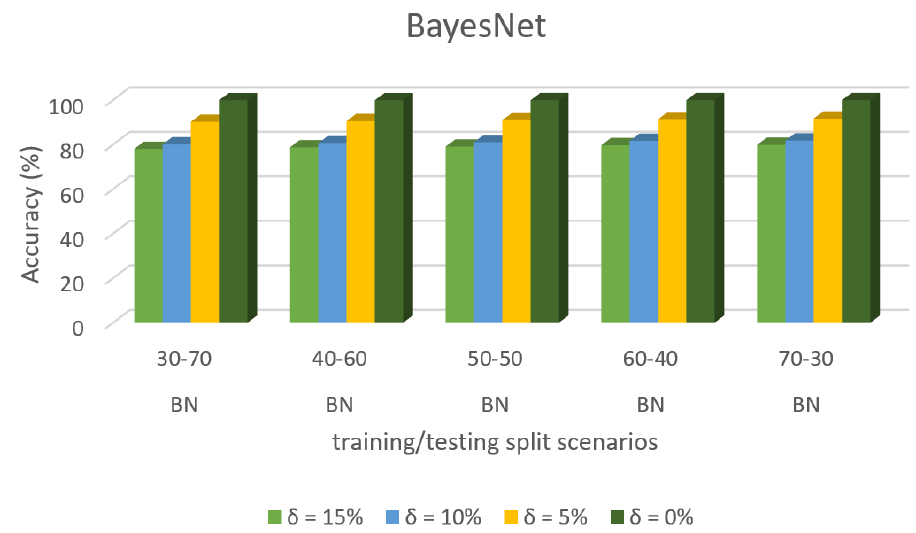
Figure 12. Accuracy Prediction for Dataset 2 using Bayesian Network Algorithm.